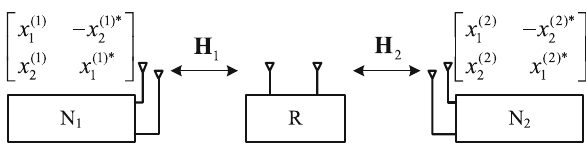
Fig. 1 Model of bidirectional STBC-CQ-PNC